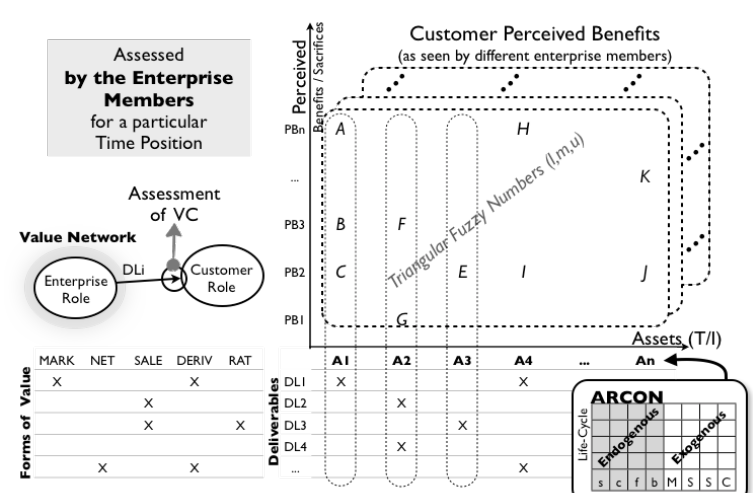
Fig. 2. Customer Perceived Value assessed by the Enterprise Members for a particular Time Position The proposed model, at this stage, pictures the perspective of the enterprise members. This shows: 1) how does the people inside the enterprise perceive the relative relevance of the assets involved in the process; and 2) how these assets relate to the Perceived Benefits (PBi)/Sacrifices (PSi) using the Saaty’s scale (Saaty, 1990). These two components are modeled as a comparison matrix of the triangular fuzzy numbers resulting from: i) each enterprise member assesses each asset relative